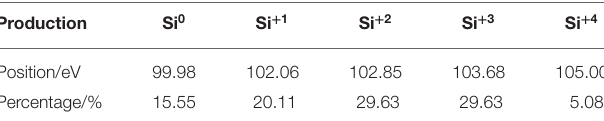
TABLE 1 | The proportion of different valence states of Si in SiO x -G/PAA-PANi/graphene.